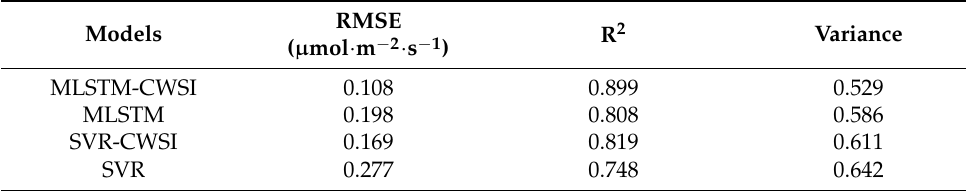
Table 2. Performance of prediction of Pn using MLSTM and SVR.